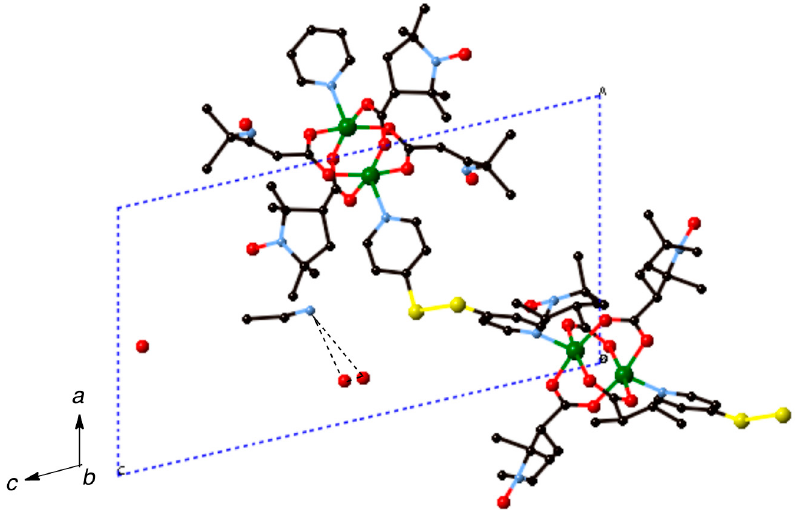
Figure 6. Perspective view of chain molecule for [Cu 2 (caproxy) 4 (pds)] n ( 6 ). Hydrogen atoms are omitted for clarity. Magnetochemistry 2018 , 4 , x FOR PEER REVIEW 9 of 16